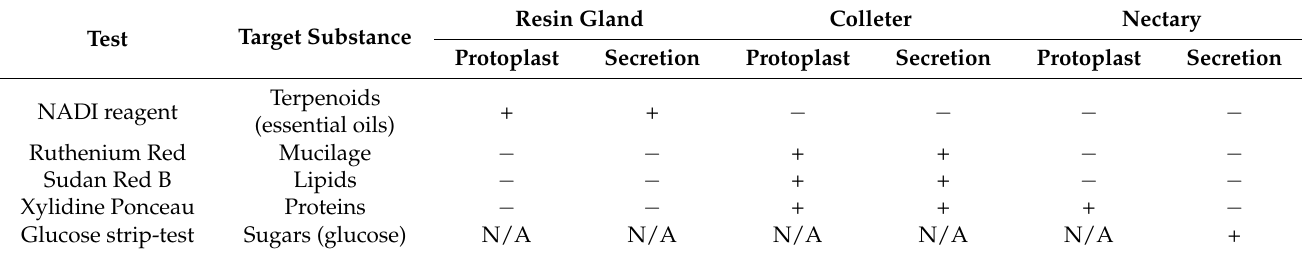
Table 1. Results for histochemical tests performed in the glands of O. castaneifolia buds and young leaves. Resin Gland Colleter Nectary Test Target Substance Protoplast Secretion Protoplast Secretion Protoplast